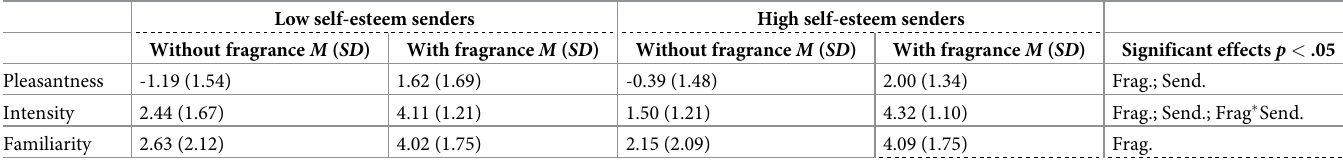
Table 2. Summary statistics for perceivers’ ( n = 62) body odor ratings of pleasantness, intensity, familiarity, with and without